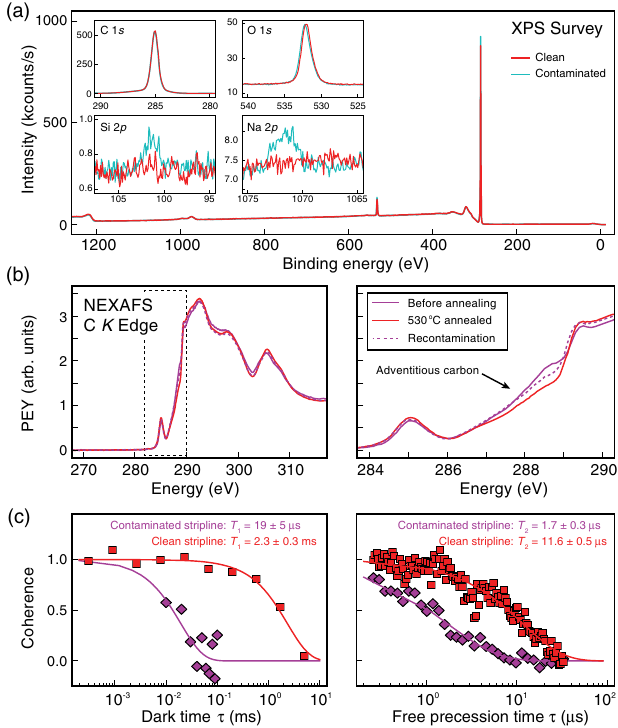
FIG. 5. (a) XPS spectra from a diamond sample with Si and Na contamination before (cyan) and after (red) acid cleaning. The main panel shows the full energy range survey scans, while insets depict higher-resolution peak scans at the C 1 s , O 1 s , Si 2 p , and Na 2 p transitions. (b) Normalized NEXAFS carbon K -edge spectra and a close-up of the preedge region of the same sample before and after in situ annealing at 530 °C, showing the removal of preedge states attributed to adventitious carbon. Dashed line shows the spectrum after reexposure to atmosphere. (c) Single- quantum relaxation and Hahn echo coherence, measured from the same NV with a contaminated strip line in which the ALD layer has been scratched, compared with a new strip Fig. 8 examples of surface roughness that can result from surface contamination and damage, and we discuss the consequences for electronic structure and NV coherence in Appendixes E and F.